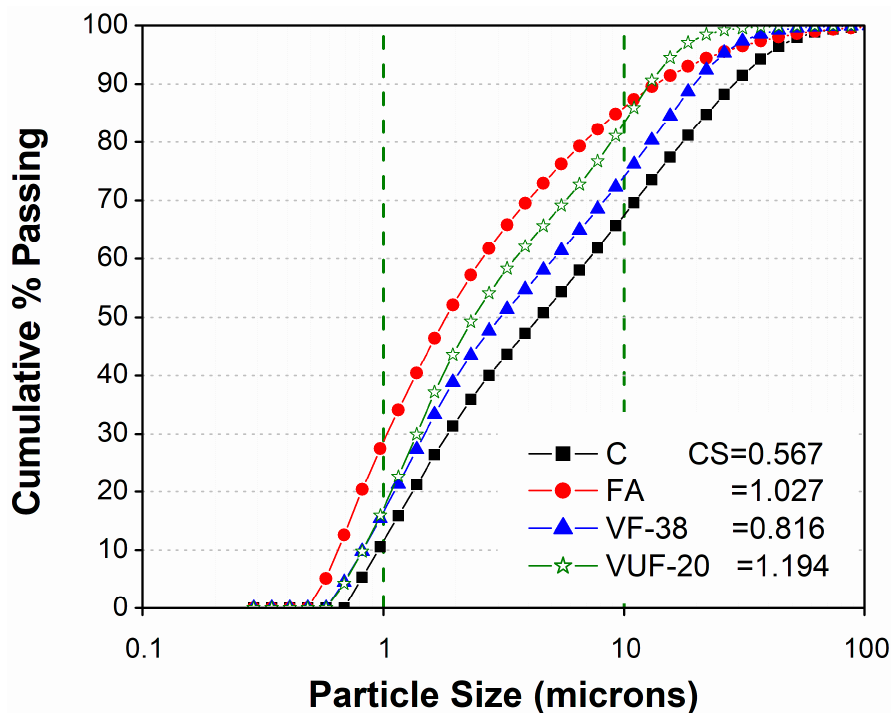
Figure 1. Particle size distribution curves of cement, fly ash, and basaltic volcanic ash of fineness VF (passed through a 38 µ sieve) and VUF (passed through a 20 µ sieve), where, CS represents Microtrac calculated SSA in m 2 /cc [36].